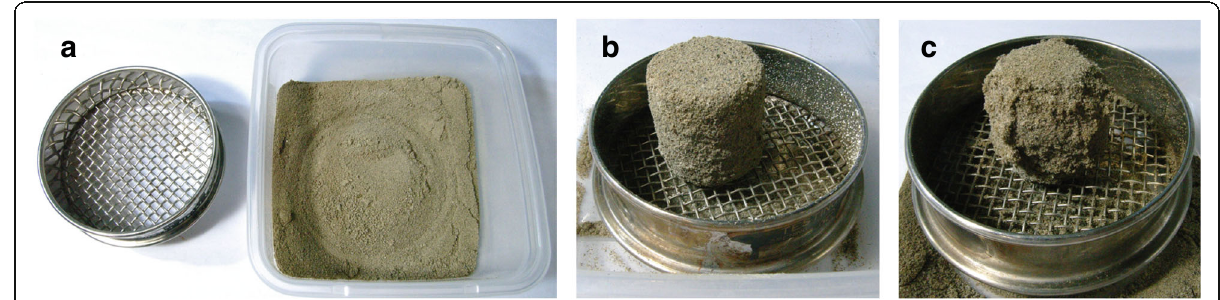
Fig. 4 Ubara sandstone samples subjected to 100 humidity-change cycles. The initial shape of each sample was cylindrical, 3.5 cm in diameter and height. The internal diameter of the sieve was 7.5 cm, and the opening was 2 mm. a NaCl caused the most intensive breakdown. The sandstone completely disintegrated into sand particles. b The specimen with Na 2 SO 4 kept its initial shape, although the sides of the cylinder showed irregular morphology due to flaking. c The specimen with MgSO 4 showed moderate weathering, although it obviously disintegrated